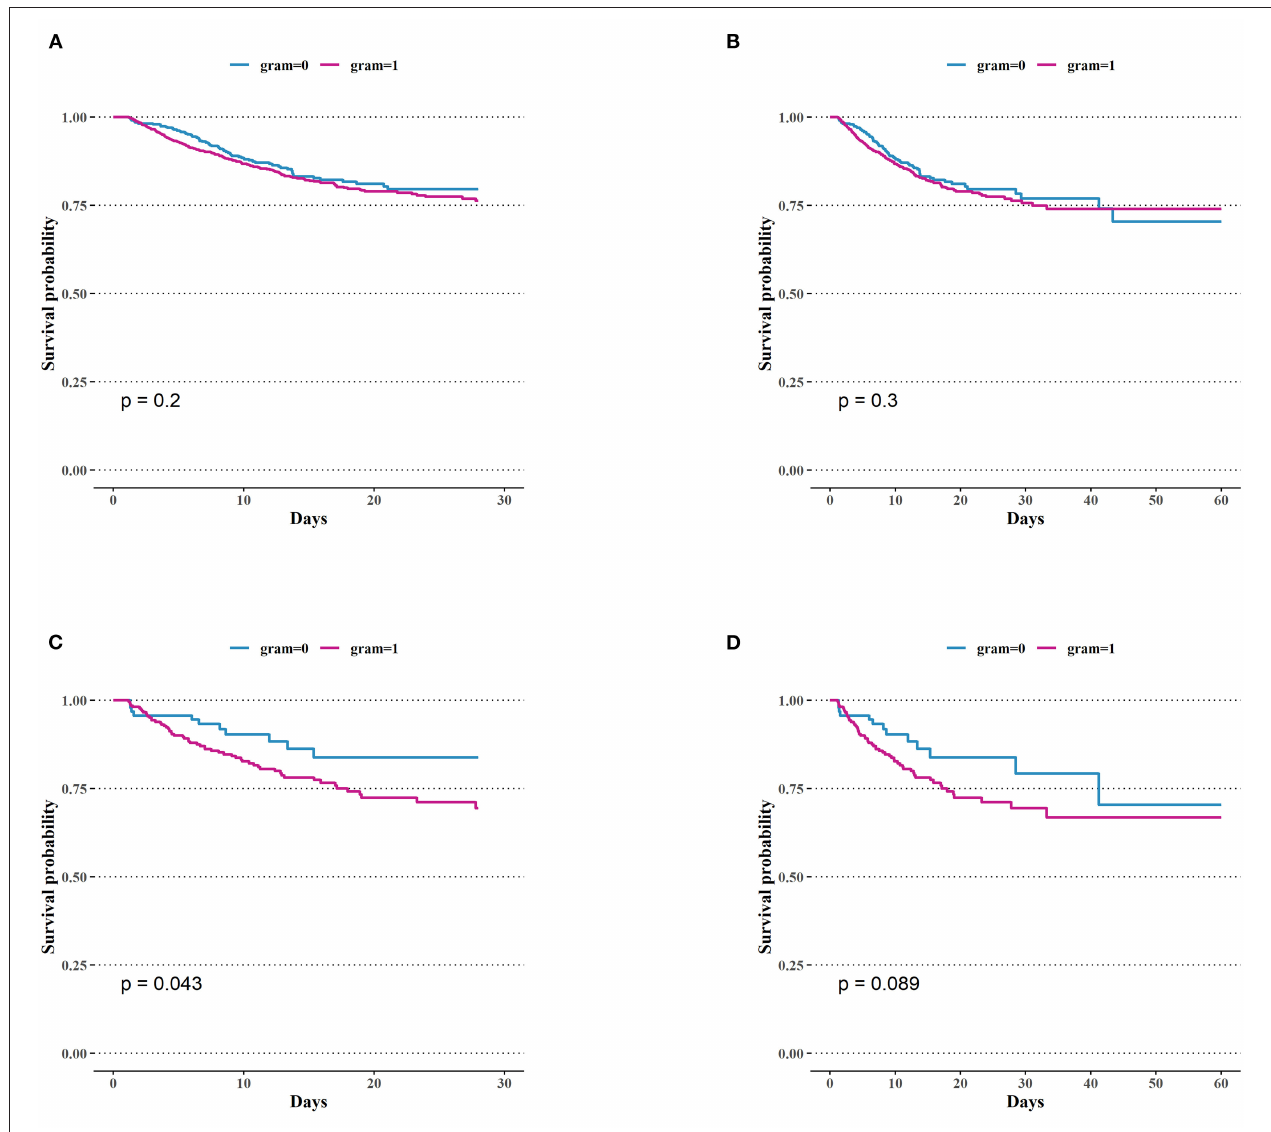
FIGURE 3 | Comparison of Kaplan–Meier survival curves between groups. (A) 28-days mortality of intensive care unit (ICU) in patients with bacteria culture Gram-positive and Gram-negative. (B) 60-days mortality of ICU in patients with bacteria culture Gram-positive and Gram-negative. (C) 28-days mortality in ICU of Gram-negative bacteria group and positive bacteria group in patients with positive blood culture. (D) 60-days mortality in ICU of Gram-negative bacteria group and positive bacteria group in patients with positive blood